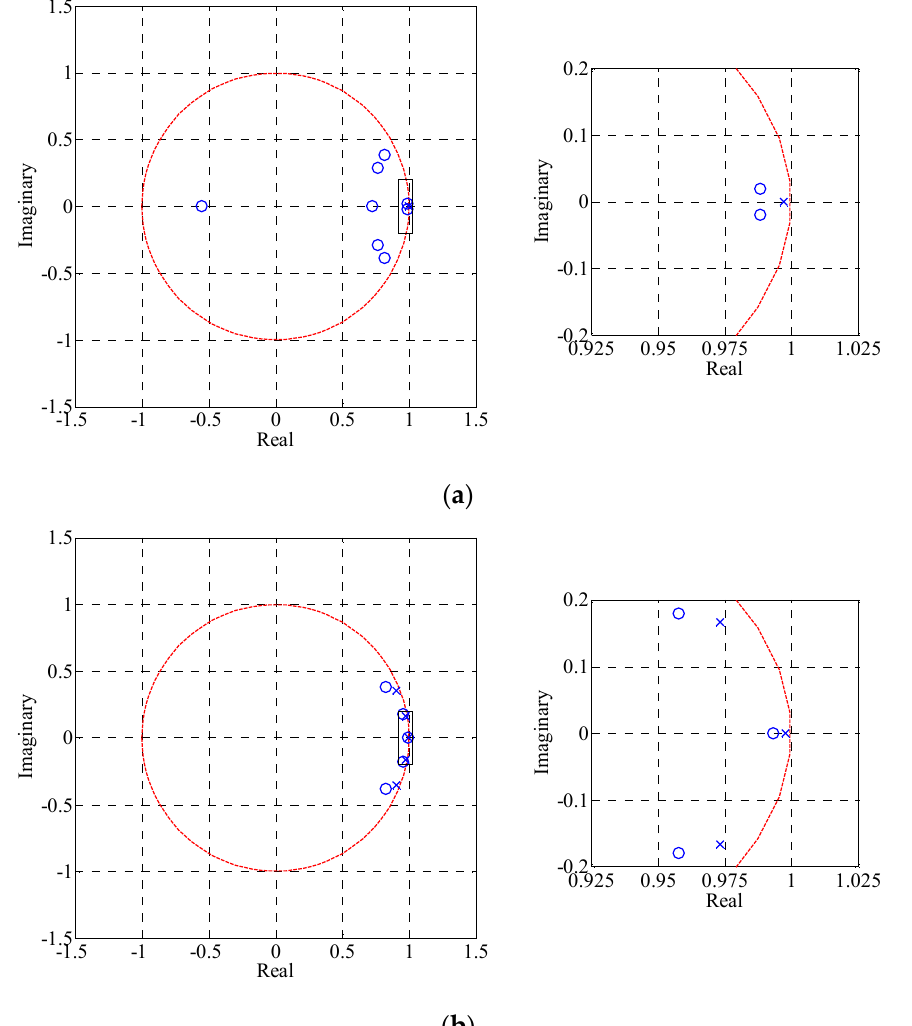
Figure 8. Pole − zero plots: ( a ) lateral direction; ( b ) vertical direction.